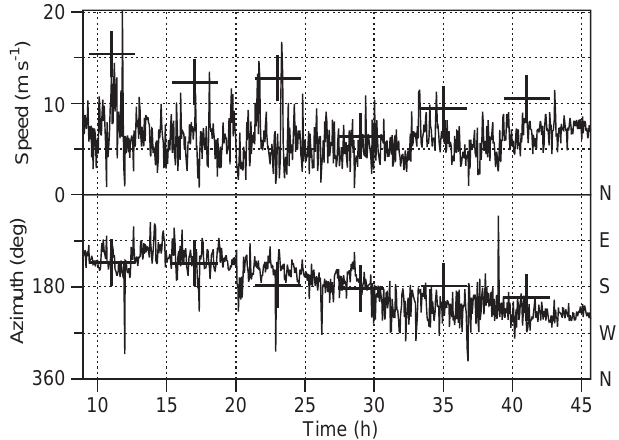
Fig. 9. Comparison of the wind speed and direction measured in the lowest radar height gates at (cid:24) 2km altitude, and by six radiosondes each averaged between 200–1000m altitude. Crosses give the radio- sonde measurements. ‘ Azimuth ’ refers to the direction the wind blows from, measured clockwise from north